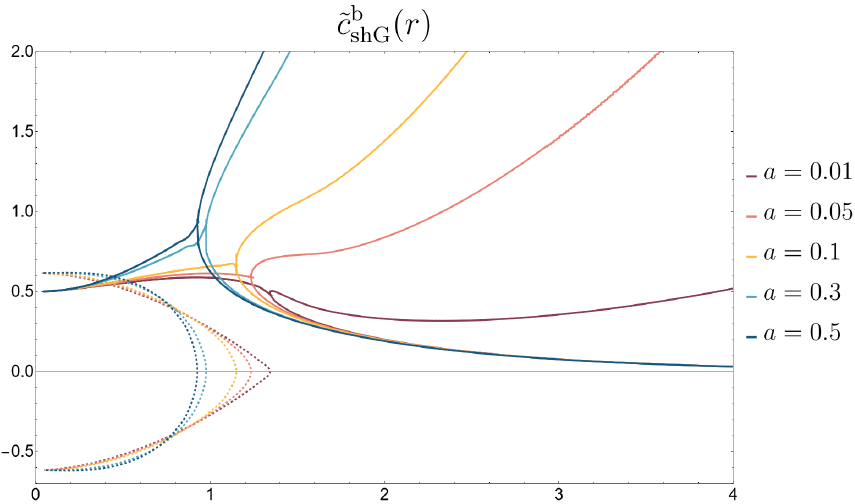
Figure 3. Effective central charge for the bosonic sinh-Gordon model at various values of the coupling a . Above a critical radius r c there are two branches of real solutions, whereas below this radius there is a pair of complex-conjugate solutions with non-vanishing imaginary parts (dashed lines). The complex effective central charge in the ultraviolet ˜ c ( r = 0) ≈ 0 . 5 ± 0 . 617 i can be computed from the plateau solutions as explained in the main text. Numerical solutions were computed using the pseudo-arclength continuation method described in section 3 with 500 points in the interval θ ∈ [ − 6 , 6)